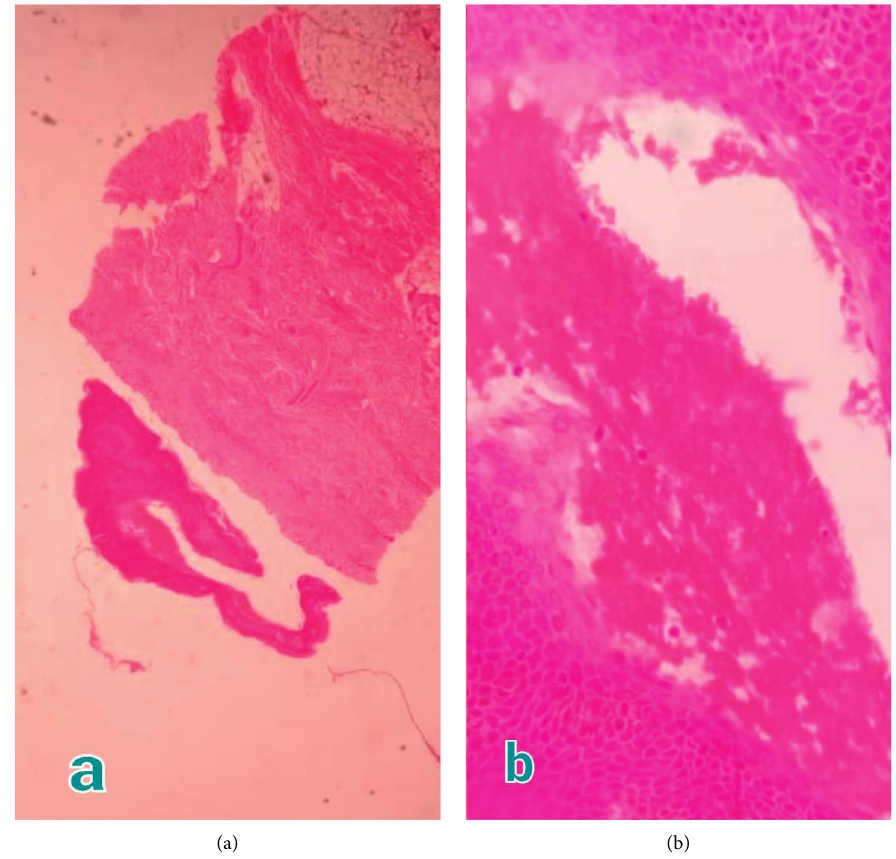
Figure 2: Distinct subepidermal bulla (H&E, x40) (a). Dermal infiltration of lymphocytes with numerous eosinophils compatible with the diagnosis of BP (H&E, x100) (b).